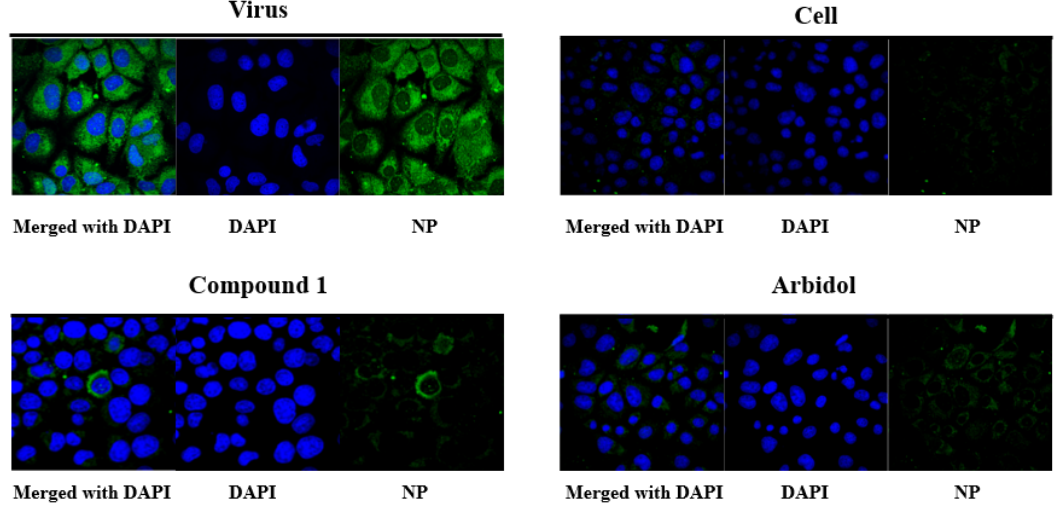
Figure 2. Anti-influenza A virus effect of compound 1 visualized by confocal microscopy (200 × ). “Virus” refers to the addition of influenza A virus into MDCK cells, while “Cell” refers to MDCK cells without the addition of virus. Viral strain: influenza A/PR/8/34 (H1N1) virus.